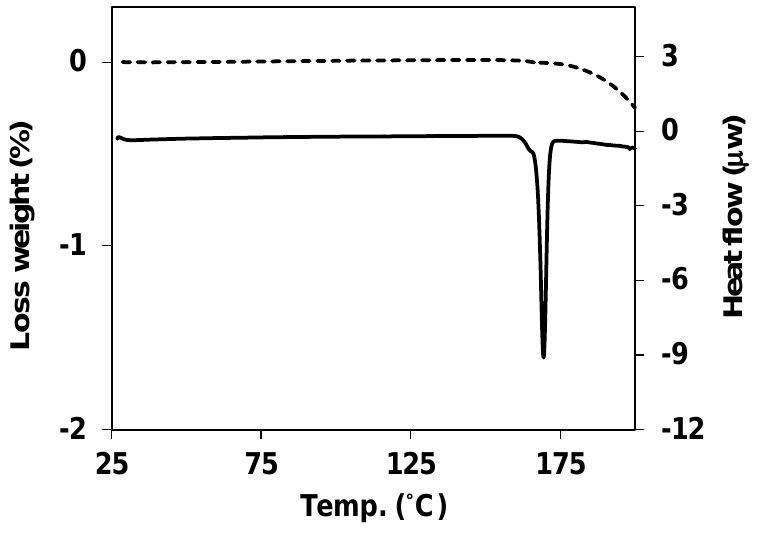
Figure 10. DSC and TG profiles of CVD_DL-MA.